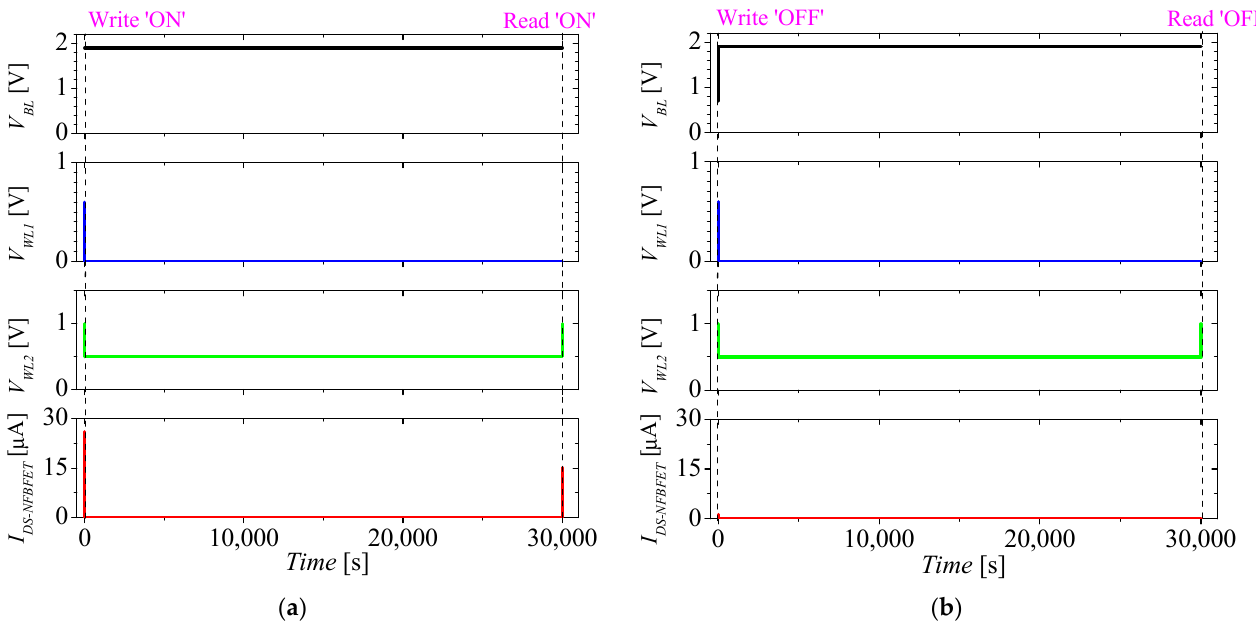
Figure 6. Retention characteristics of the M3D − FBFET − SRAM cell when the recursive reading pulse is applied after ( a ) writing ‘ON’ operation, and ( b ) writing ‘OFF’ operation.